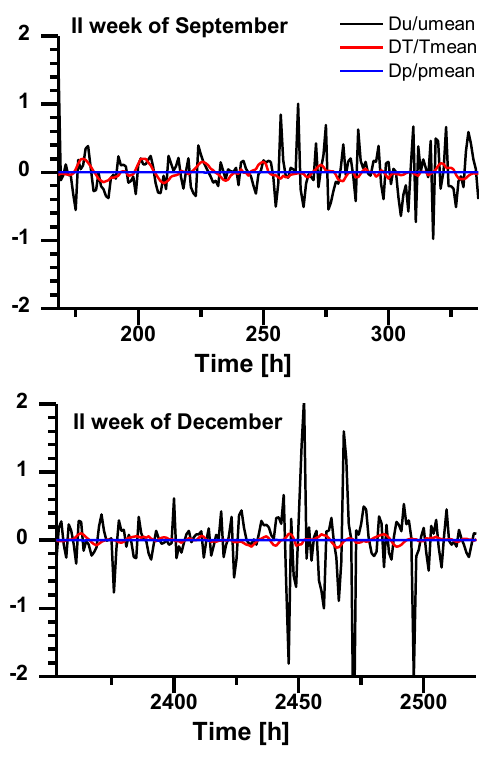
Figure 11. Temporal variability of NWP data in two different weeks of